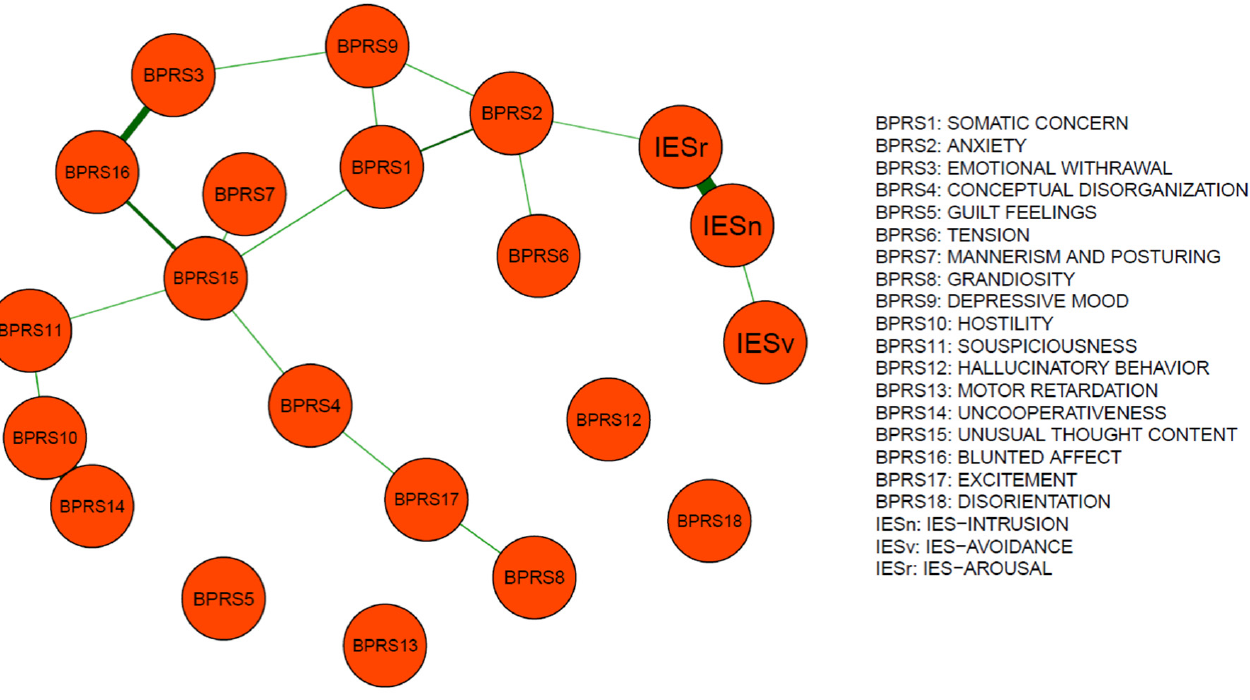
Figure 2. Network structure in the November sample. Edge weights reflect the connection strength of BPRS factors with IES-R dimensions in the November network.